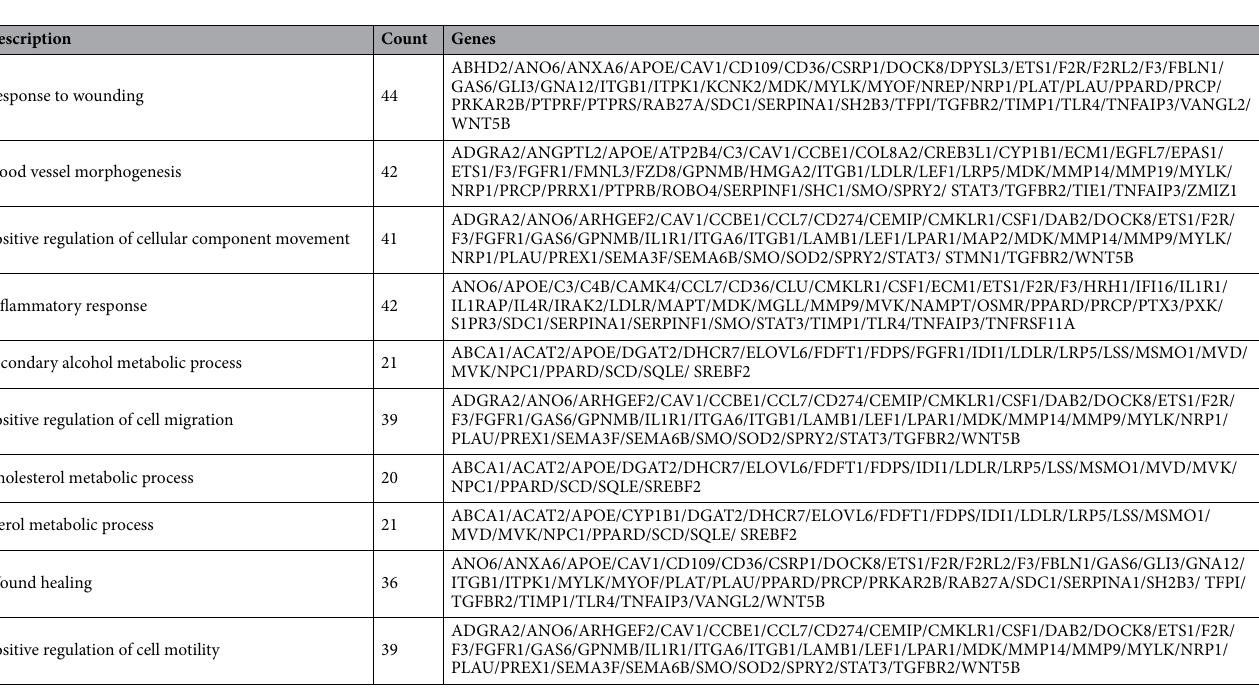
Table 2. Gene Set Enrichment Analysis was performed on differentially expressed transcripts in ARPE-19 cells with modified EMP2 levels, with the top 10 Go ontology terms from Group 2 (EMP2 < WT < KD)